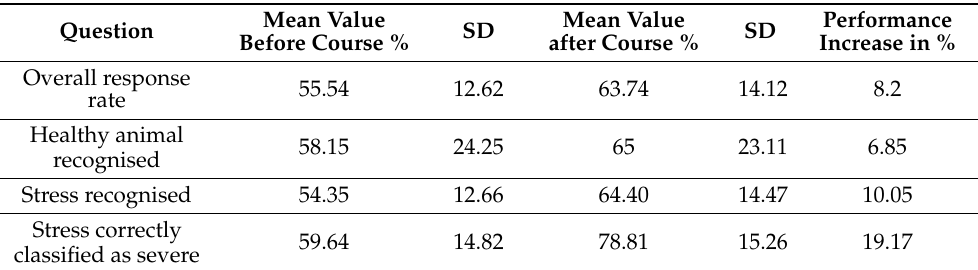
Table 1. Comparison of the stress assessment of the course participants before and after the course for the acquisition of basic animal expertise: The course participants achieved significantly better results after the course with regards to all questions (evaluation according to Bonferroni: p -value < 0.001) than before the course. SD = standard deviation.